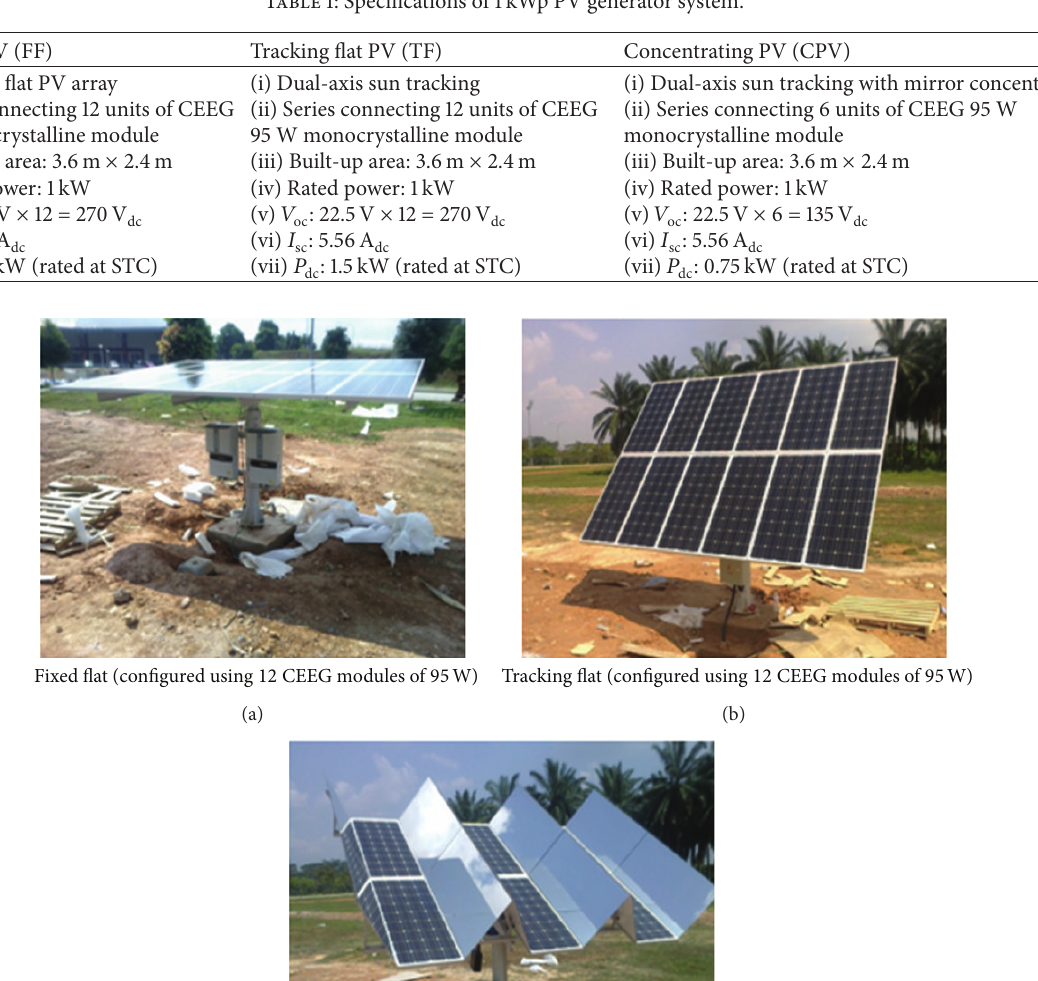
Table 1: Specifications of 1kWp PV generator system.